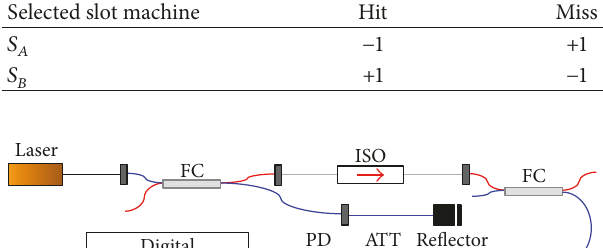
Table2:Parametervaluesusedfornumericalsimulationofdecision